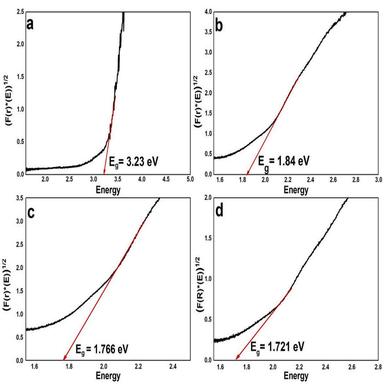
Bandgap of prepared samples a) Pristine BTO, b) 1% Fe doped BTO, c)2% Fe doped BTO & d)3% Fe doped BTO.